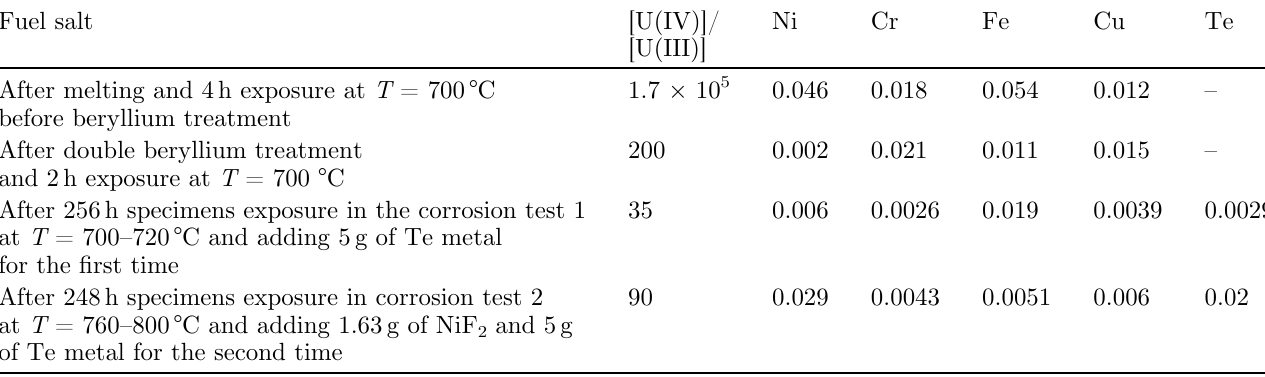
Table 1. The [U(IV)]/[U(III)] ratio and metal impurities (wt.%) content in the fuel 71.2LiF-26.8BeF before and after corrosion